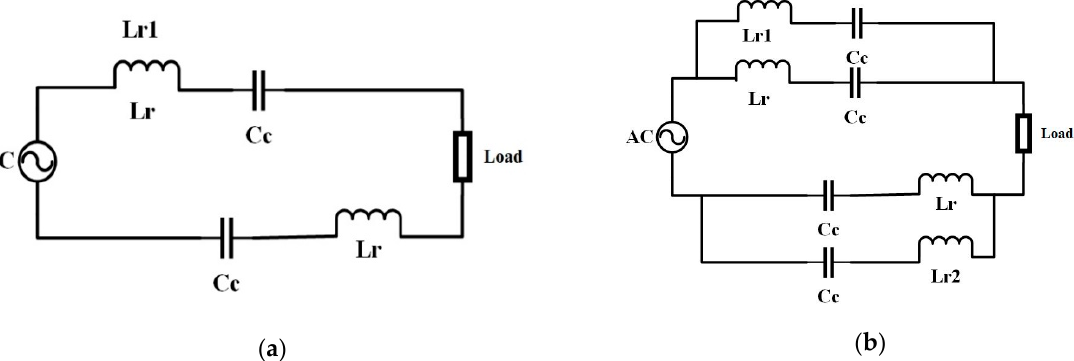
Figure 2. Framework of 8-plate multi-resonant coupling structure: ( a ) 4-plate coupling equivalent circuit and ( b ) 8-plate multi-resonant coupling equivalent circuit.